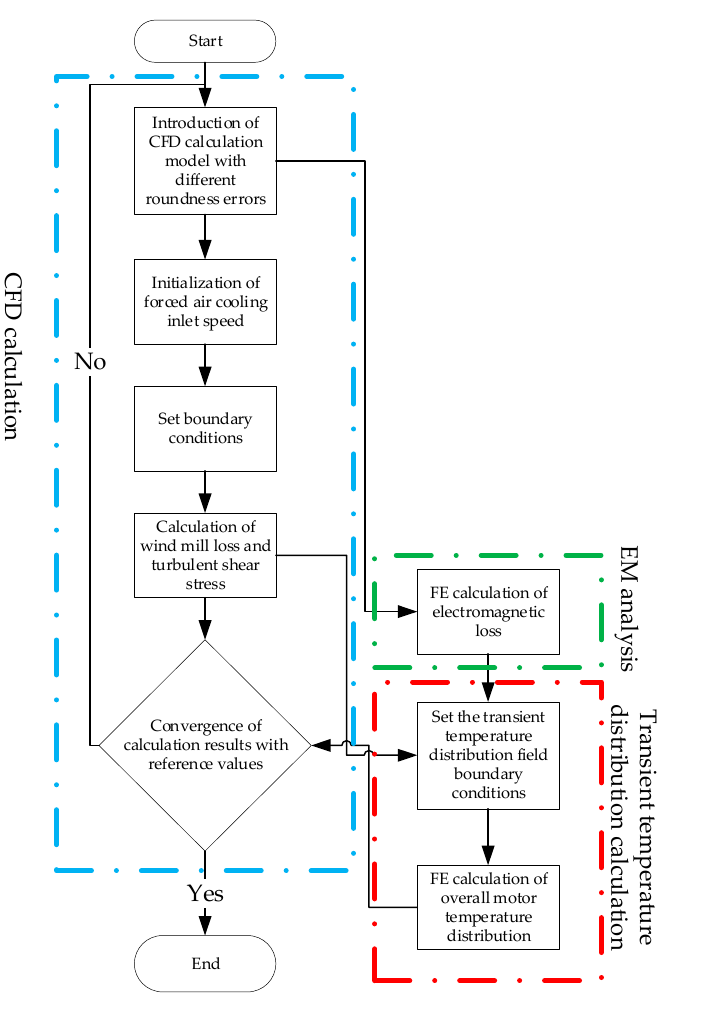
Figure 19. FE calculation process.